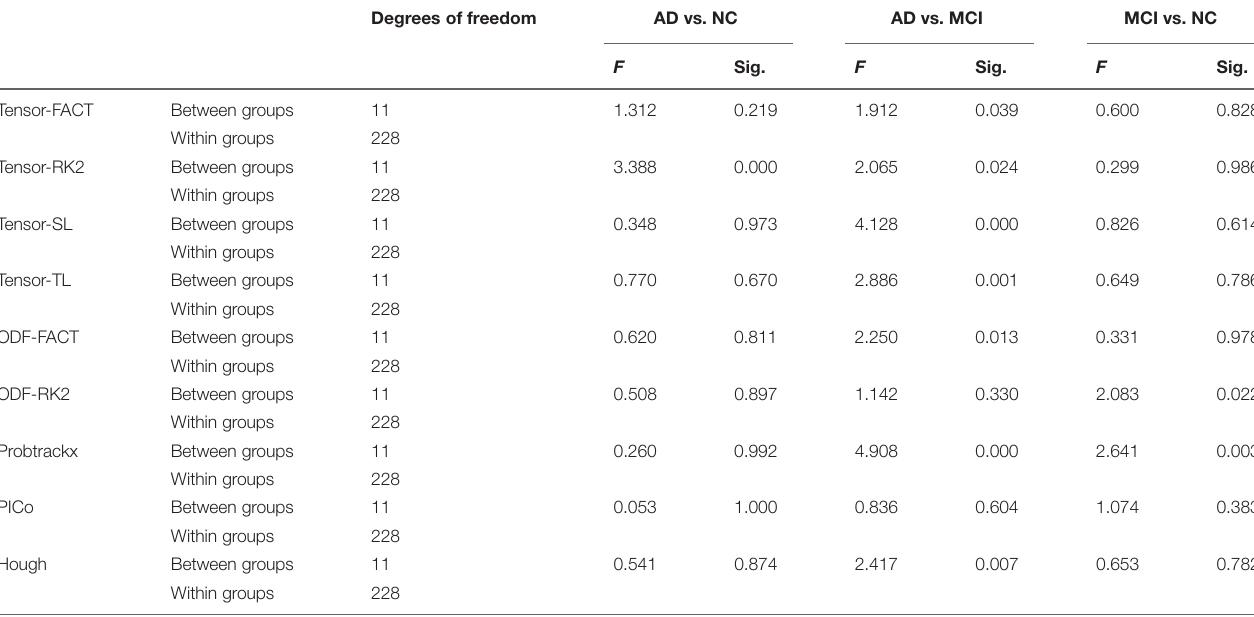
TABLE 5A | One-way ANOVA test on the classification performances across different numbers of PCs for nine tractography algorithms in three diagnostic tasks. Degrees of freedom AD vs. NC AD vs. MCI MCI vs. NC F Sig. F Sig. F Sig.